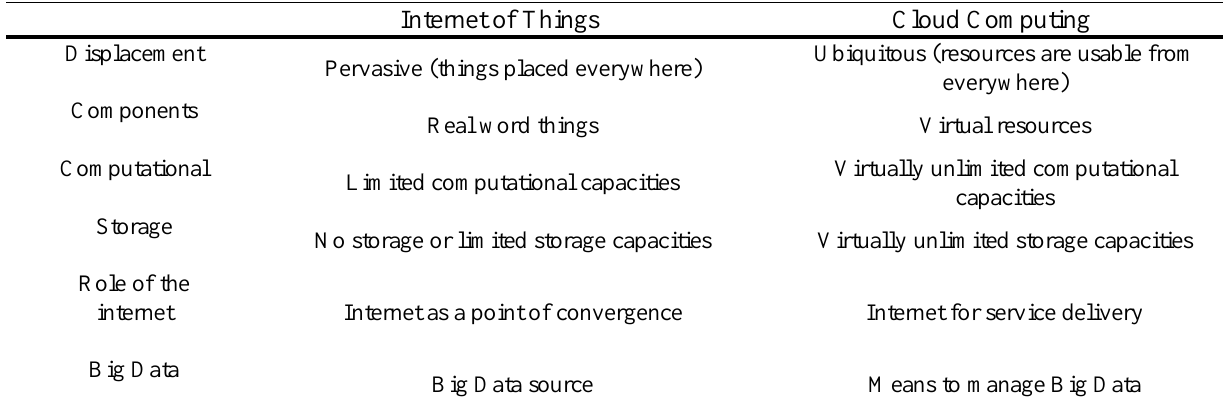
Table 1. Complementary characteristics of cloud and